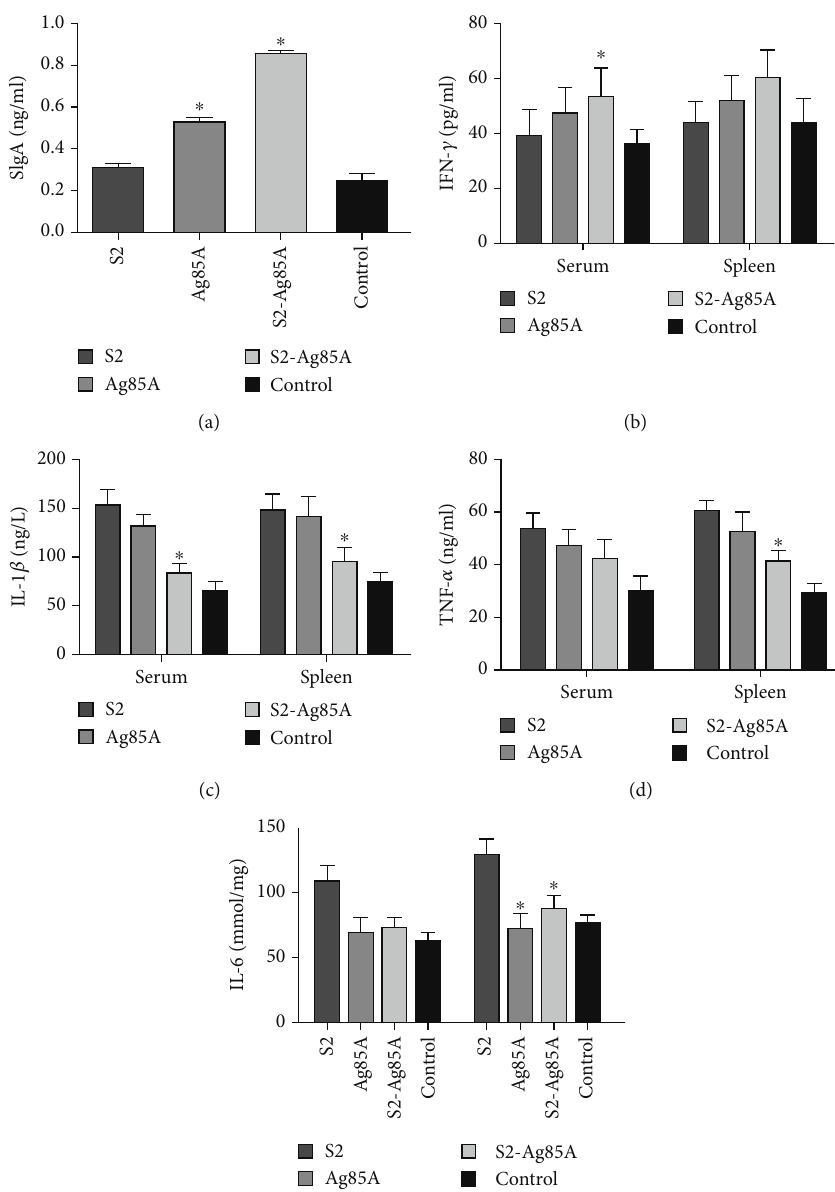
Figure 5: Enhancement of the cytokines stimulation by S2-Ag85A oral vaccine in mice. (a) The signi fi cantly elevated level of SIgA secreted by S2-Ag85A in the intestinal tract of mice than that in the S2 group ( P value < 0.05). (b) The secretion of SIgA is augmented in peripheral serum and spleen tissue of mice after the application of S2-Ag85A vaccine. (c) The level of IL-1 β is inhibited in peripheral serum and spleen tissue of mice after the application of S2-Ag85A vaccine ( P value < 0.05). (d) The level of TNF- α is inhibited in the mouse spleen tissue after the application of S2-Ag85A vaccine ( P < 0 : 05 ). (e) The level of IL-6 is inhibited in the mouse spleen tissue after the application of S2-Ag85A vaccine ( P < 0 : 05 ). ∗ P value < 0.05 compared with the S2